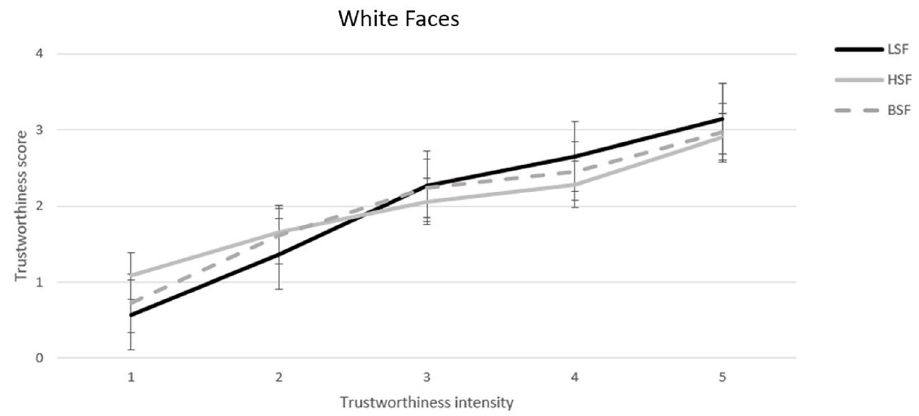
Fig 3. Mean trustworthiness scores for each of the five White faces composing the trustworthiness continuum in the Low-Spatial-Frequency (LSF), the High-Spatial-Frequency (HSF), and the Broad-Spatial-Frequency (BSF) conditions. Error bars refer to standard errors of the